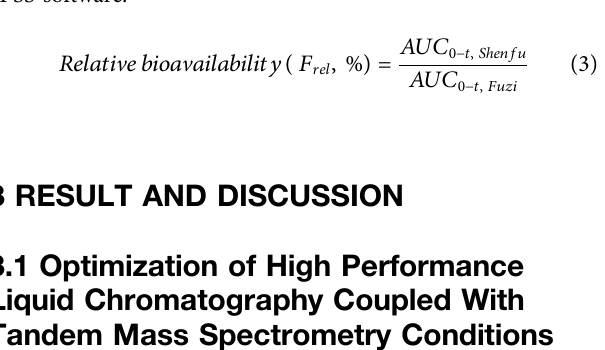
Shenfu group was performed by independent samples t-test with SPSS software.